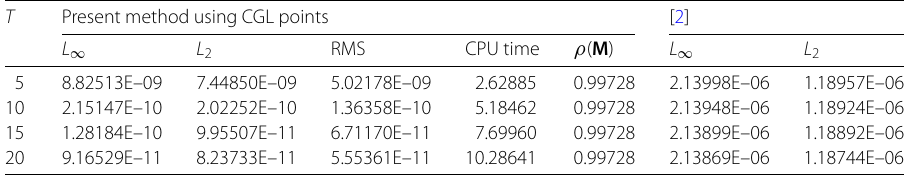
Table 8 Error norms and spectral radius for the solution of Example 2 in Case 2.2